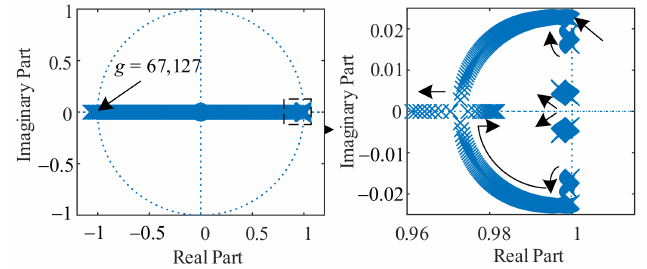
Figure 3. Pole distribution diagram of A e when g